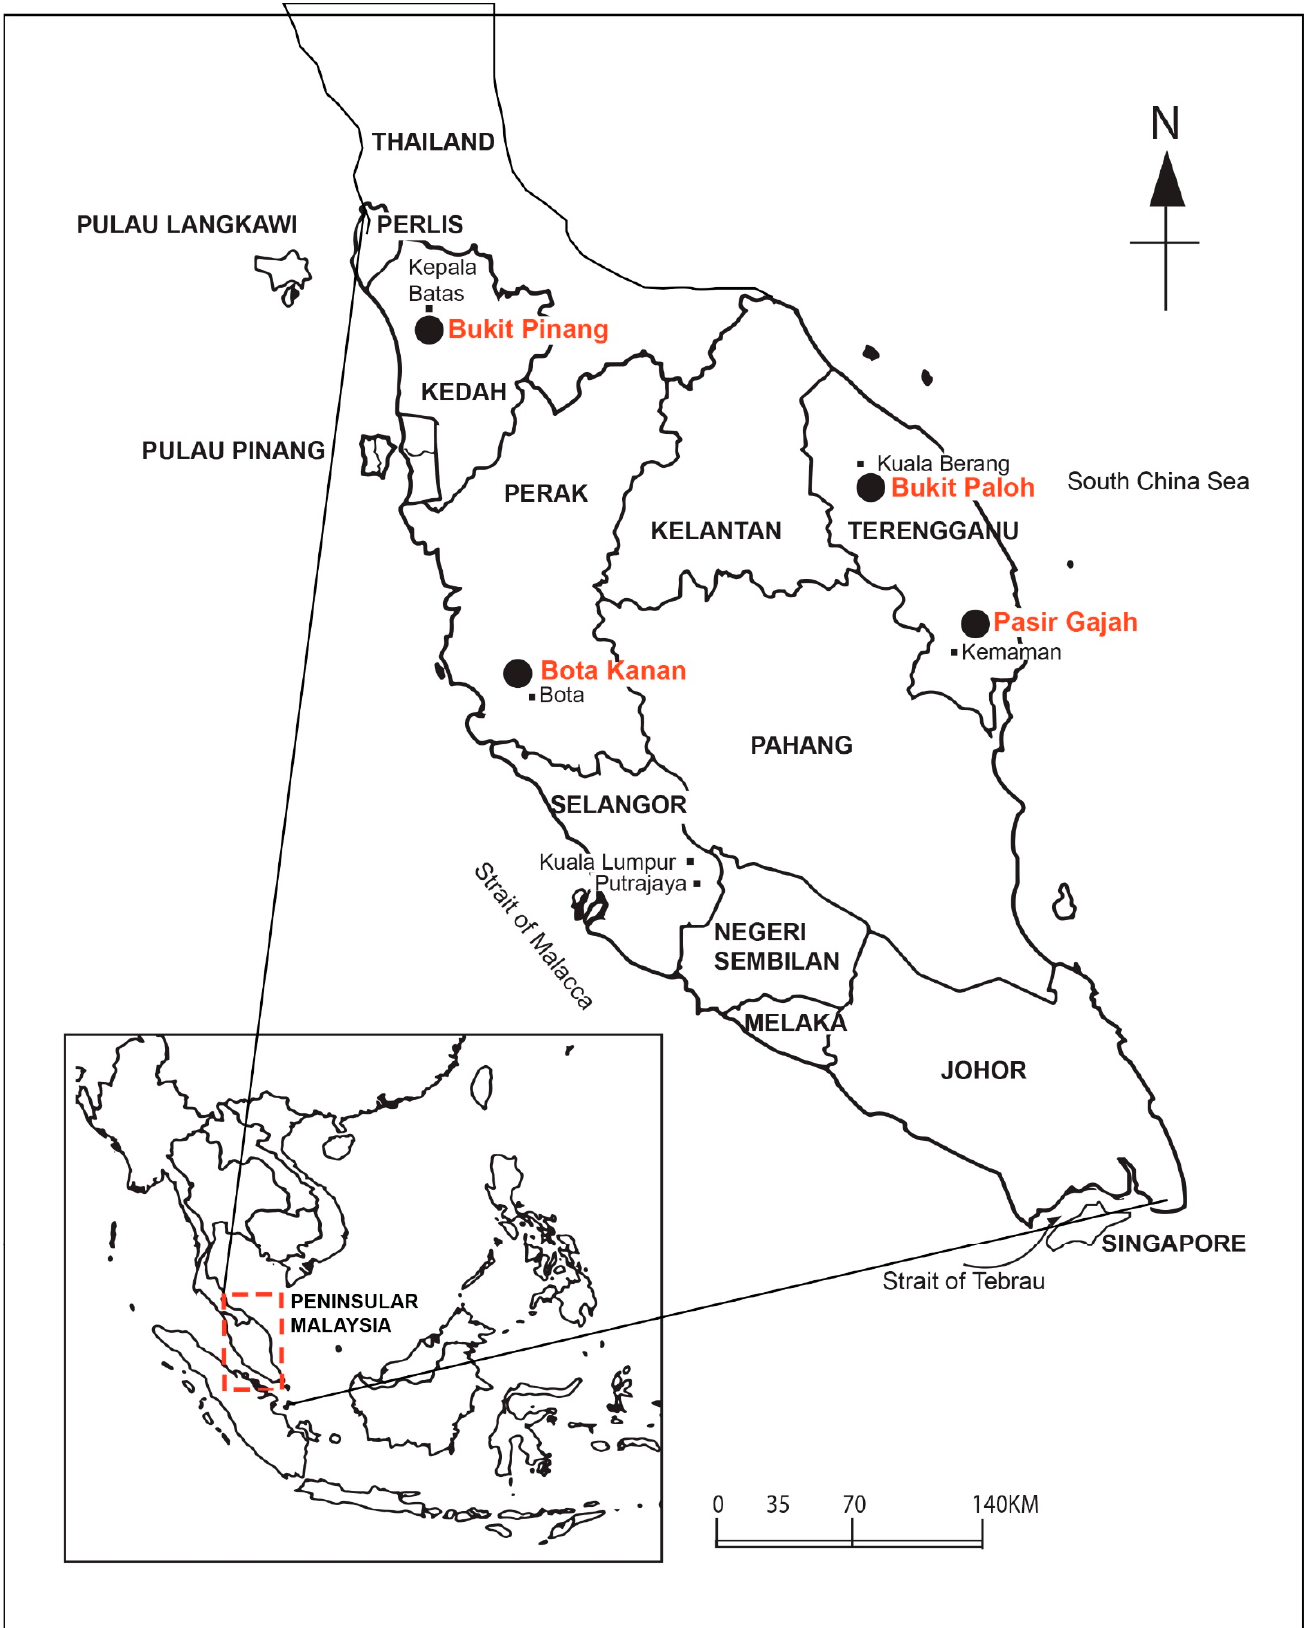
Figure 1. Sampling locations of Batagur affinis in four areas of peninsular Malaysia.